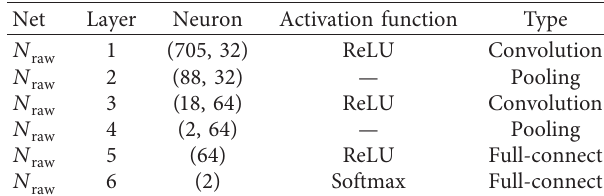
Table 2: Network details of N